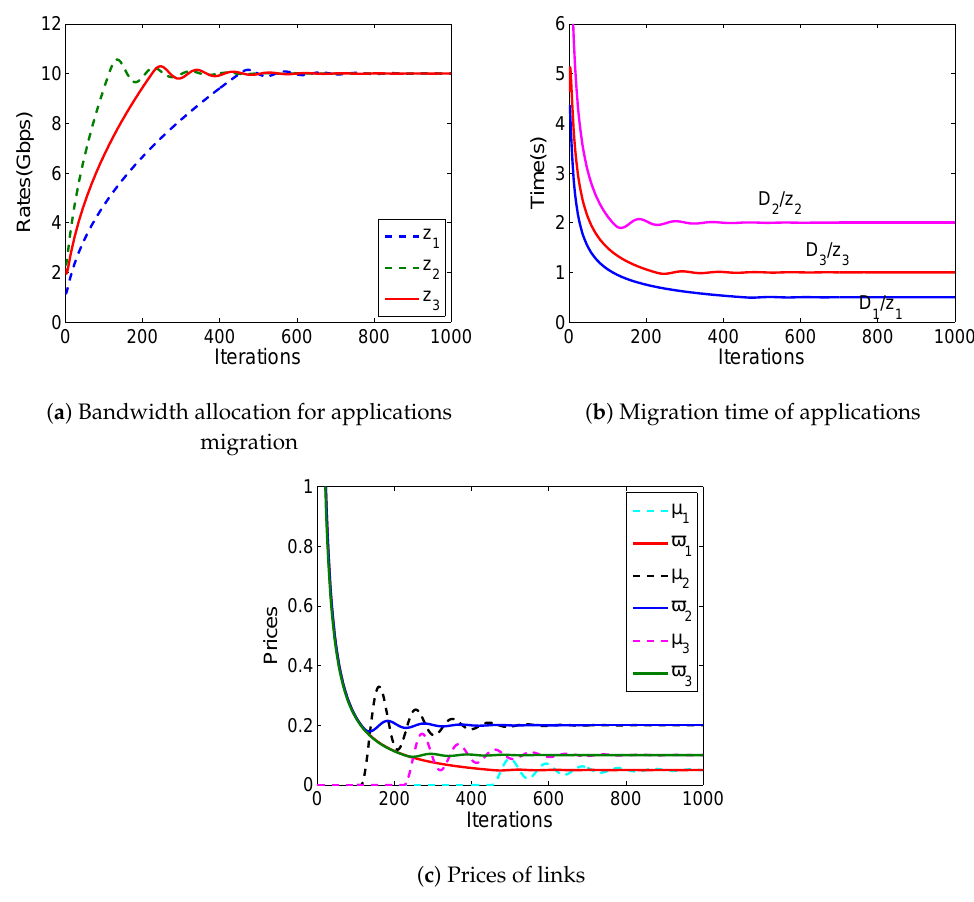
Figure 5. Performance of the bandwidth allocation algorithm for application migration with ϑ = 0.1 and ς =